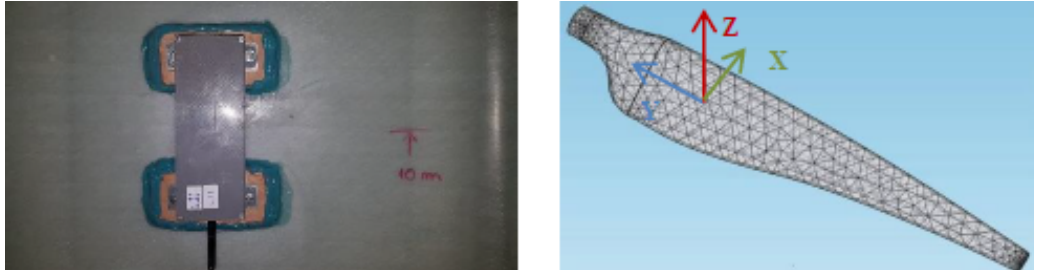
Figure 15. MEM-based system installed inside one blade and direction of measurements ( X approximately aligned with edge-wise direc- tion).